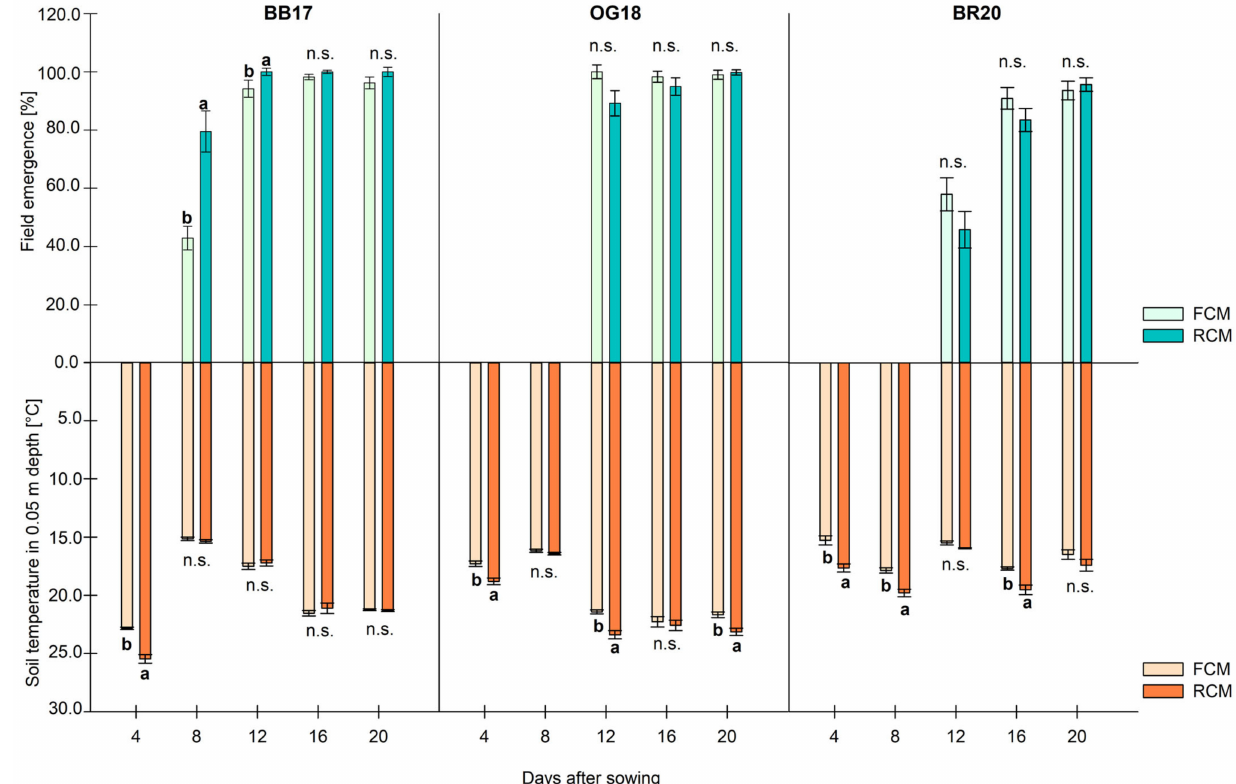
Figure 4. Field emergence and soil temperature at 0.05 m soil depth 4, 8, 12, 16 and 20 days after sowing in flat cultivation method (FCM) and in ridge cultivation method (RCM) over all Ennvi- ronments (Bösenbrunn 2017—BB17, Oberhermsgrün 2018—OG18, Bergen 2020—BR20). Arithmetic means ± standard error. Tukey-Kramer, significance at p < 0.05. Different letters indicate significance and n.s.—not significant for the respective day after sowing, separately for field emergence and soil